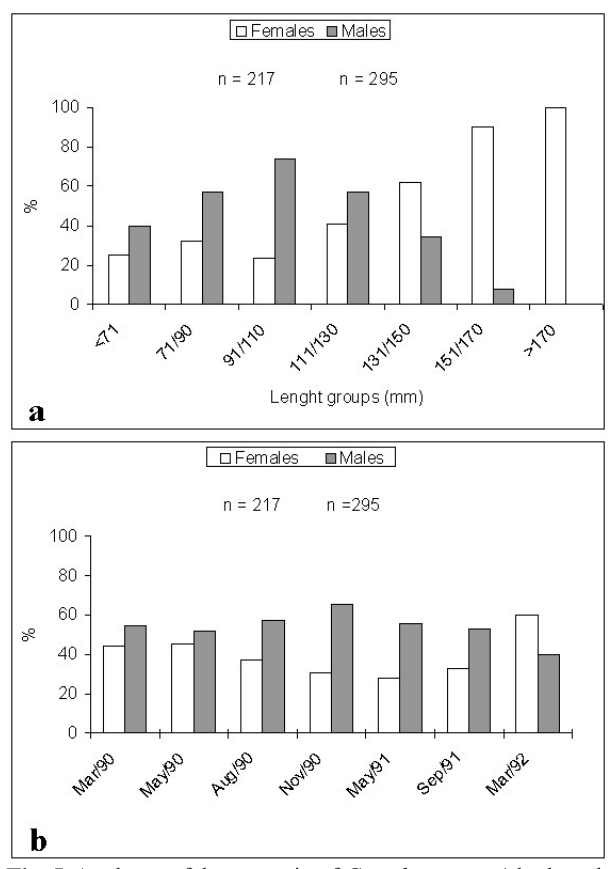
Fig. 4 . Mean values of the alometric condition factor (K) and “K estimated to C. spilopterus in the Mamanguá Inlet.